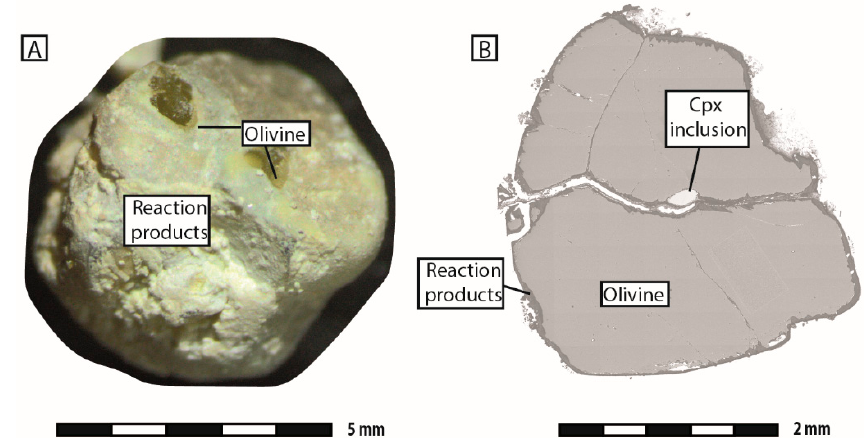
Figure 2. ( A ) Optical micrograph and ( B ) BSE image of an olivine grain after six months of reaction in NaOH solution (run # 2). Note the external and internal changes in texture with respect to the starting olivine grain shown in Figure 1. Cpx: clinopyroxene.